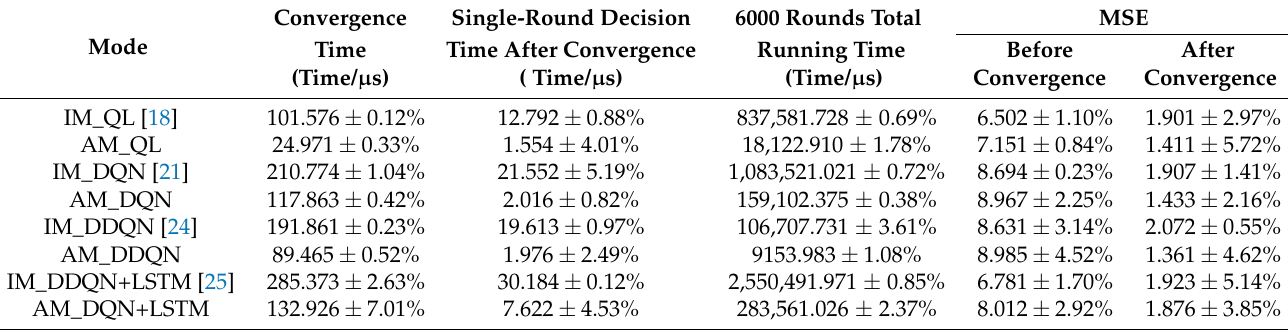
Table 6. Experimental comparison of processing time of classic RL algorithms under IM and AM. Convergence Single-Round Decision 6000 Rounds Total MSE Mode Time Time After Convergence Running Time Before After (Time/ µ s) ( Time/ µ s) (Time/ µ s) Convergence Convergence IM_QL